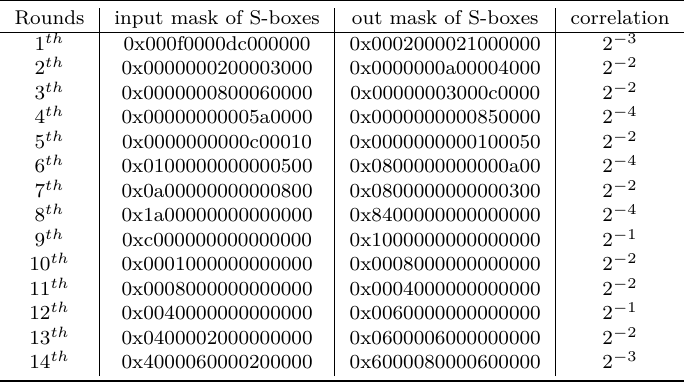
Table 13: The best linear characteristic with correlation 2 − 34 for 14-round RECTANGLE.